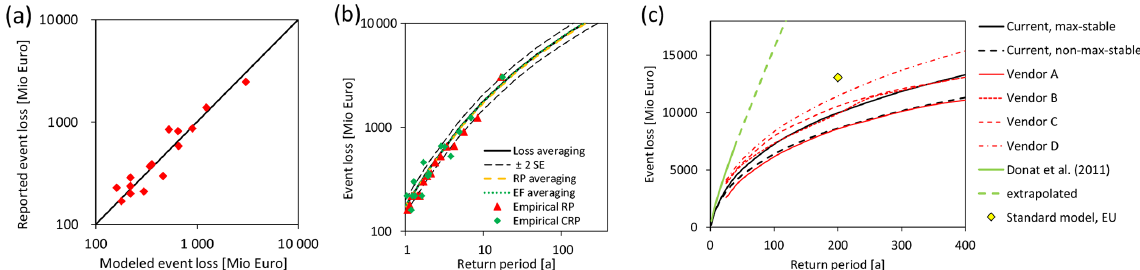
Figure 7. Estimates for insured losses from winter storms in Germany: (a) reported versus modeled event losses, (b) current risk curves and observations, and (c) influence of max-stable and non-max-stable scaling and comparison to scaled, previous estimates (Donat et al., 2011; Waisman, 2015; European Commission,